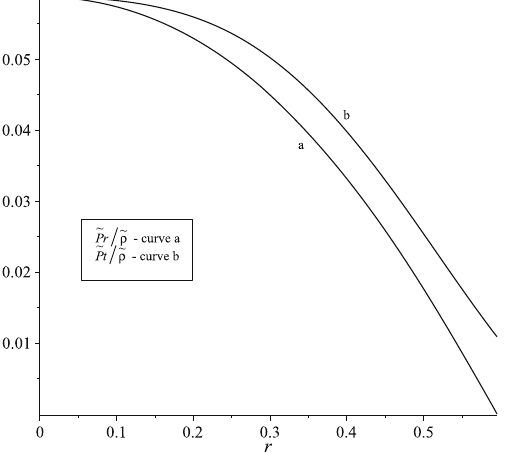
Fig. 11 Dominant energy condition for the solution obtained with the first algorithm with F (cid:9)= 0 from the isotropic Gold III solution